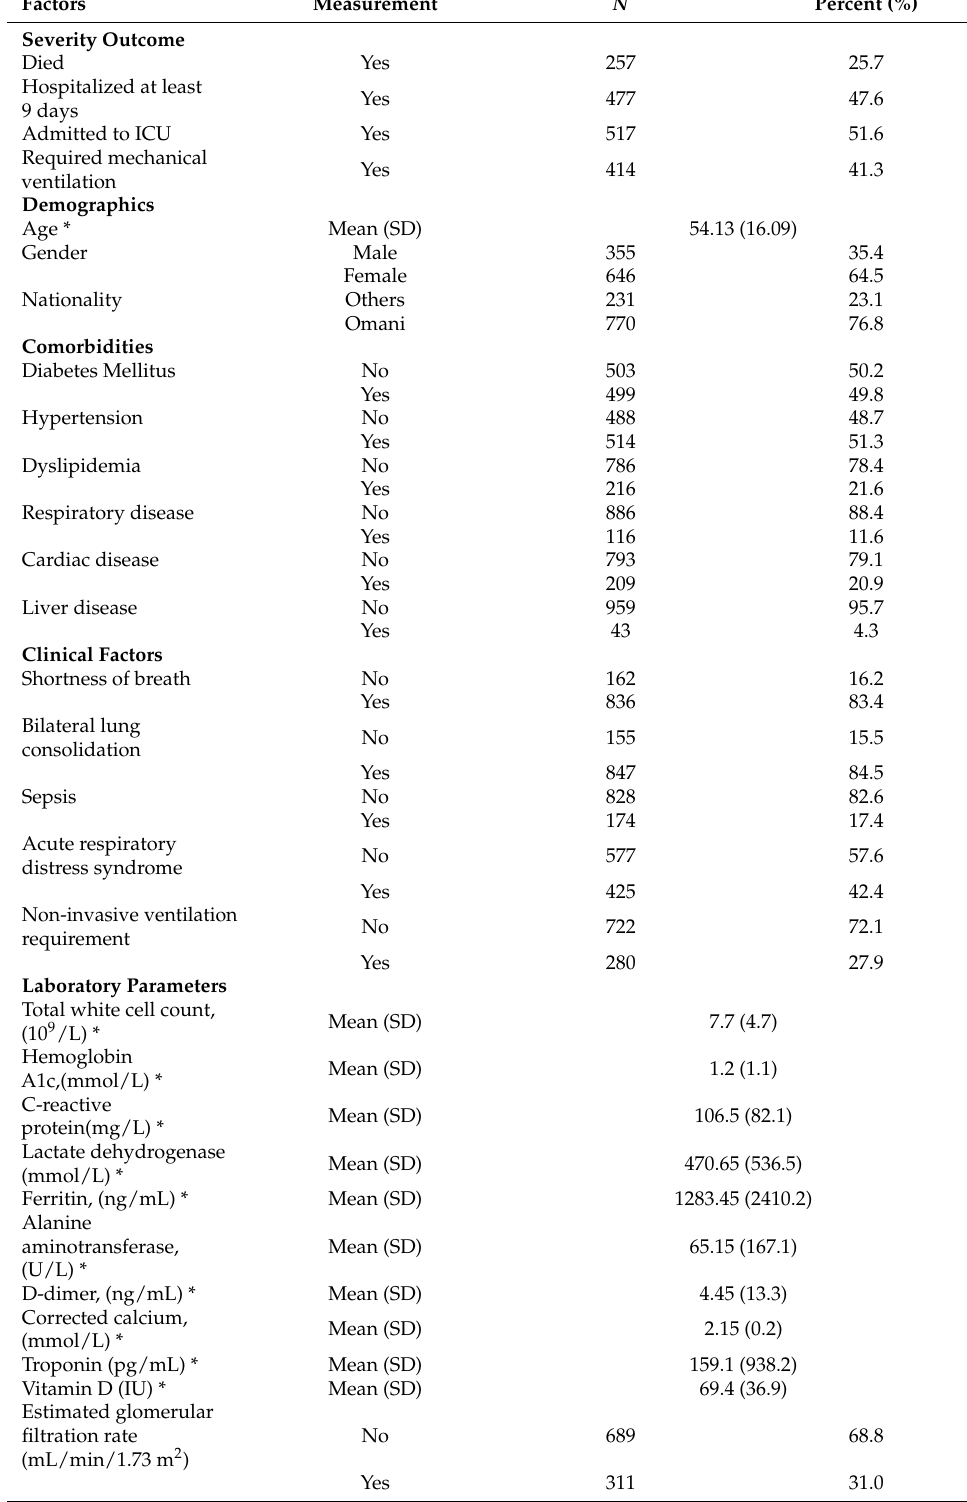
Table 1. Descriptive characteristics of the COVID-19 hospitalized patients ( N =